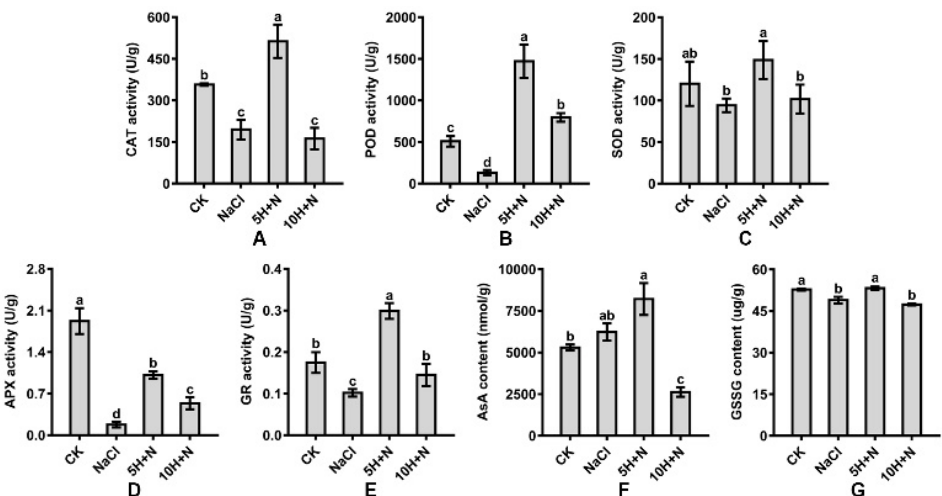
Figure 6. Effects of exogenous H 2 O 2 on CAT ( A ), POD ( B ), SOD ( C ), APX ( D ), GR ( E ), AsA ( F ), and GSSG ( G ) of Tartary buckwheat under NaCl stress. CK: control, H 2 O foliar spray + H 2 O irrigation, NaCl: H 2 O foliar spray + 150 mmol·L − 1 NaCl irrigation, 5H + N: 5 mmol·L − 1 H 2 O 2 foliar spray + 150 mmol·L − 1 NaCl irrigation, 10H + N: 10 mmol·L − 1 H 2 O 2 foliar spray + 150 mmol·L − 1 NaCl irrigation. CAT: catalase activity, POD: peroxidase activity, SOD: superoxide dismutase activity, APX: ascor- bate peroxidase activity, GR: glutathione reductase activity, AsA: ascorbic acid content, GSSG: glu- tathione oxidized content. All values are expressed as mean ± SD. According to Duncan’s multiple comparisons, different letters represent significant differences among different treatments ( p < 0.05).